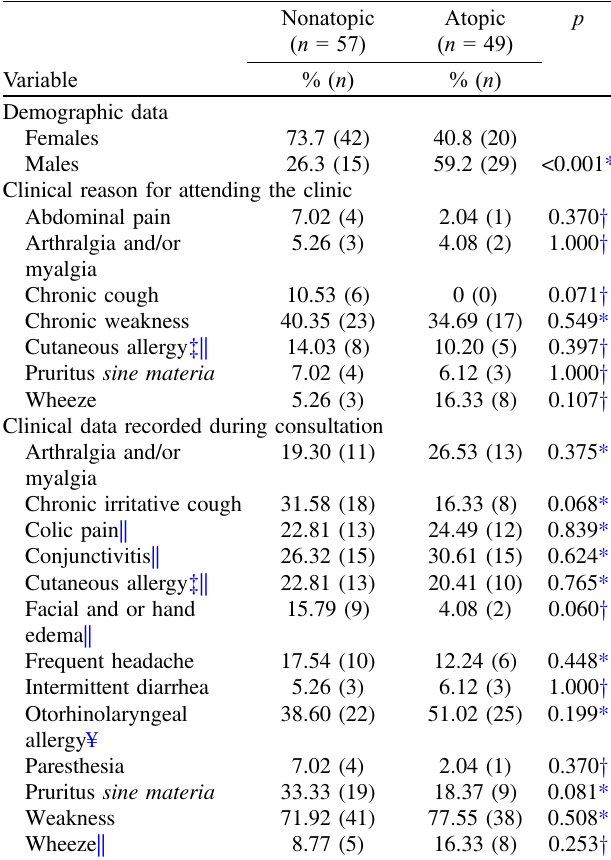
Table 1. Bivariate analysis of demographic and clinical categorical variables recorded in 106 toxocariasis